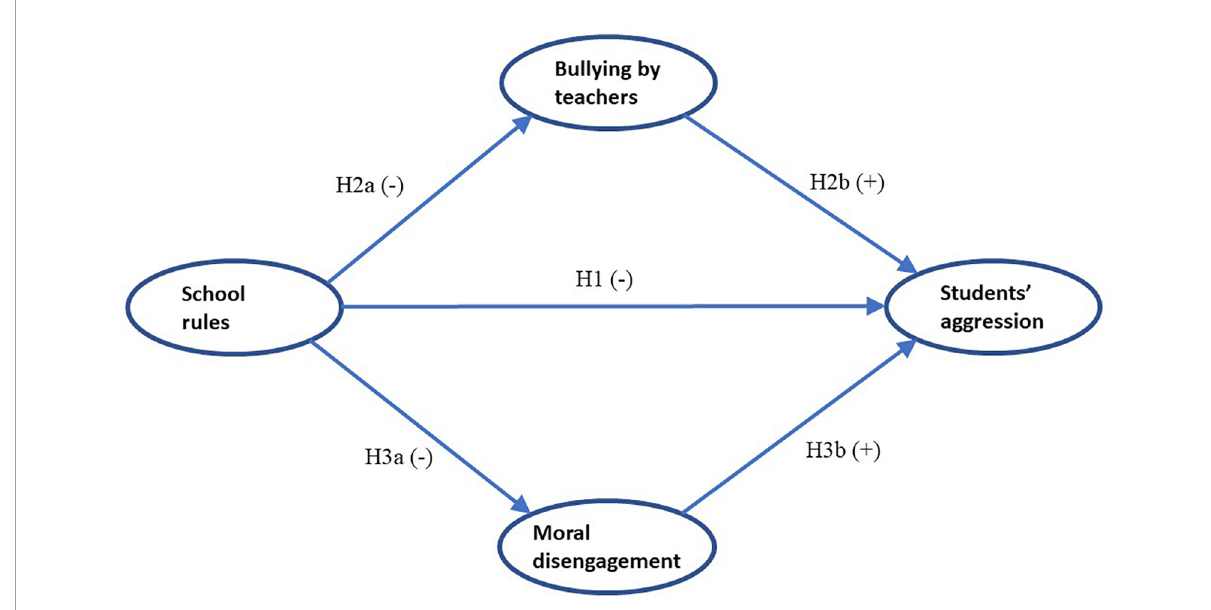
FIGURE1 Hypothesized model.